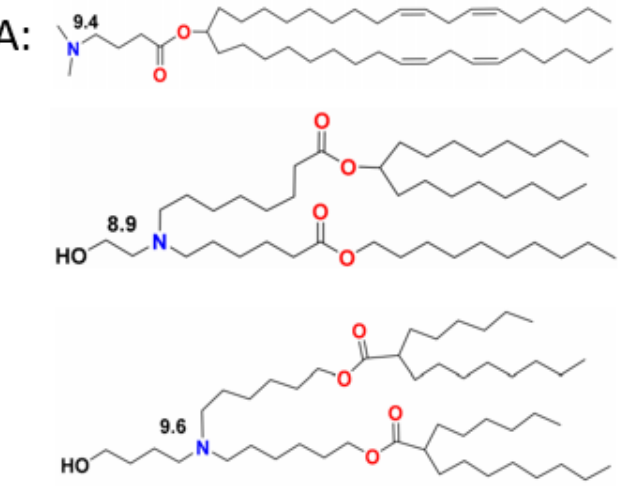
Figure 4. Structure and pK a value of DLin-MC3-DMA ( A ), SM-102 ( B ), and Alc-0315 ( C ). Copyright is reserved by 1996–2022 MDPI (Basel, Switzerland).